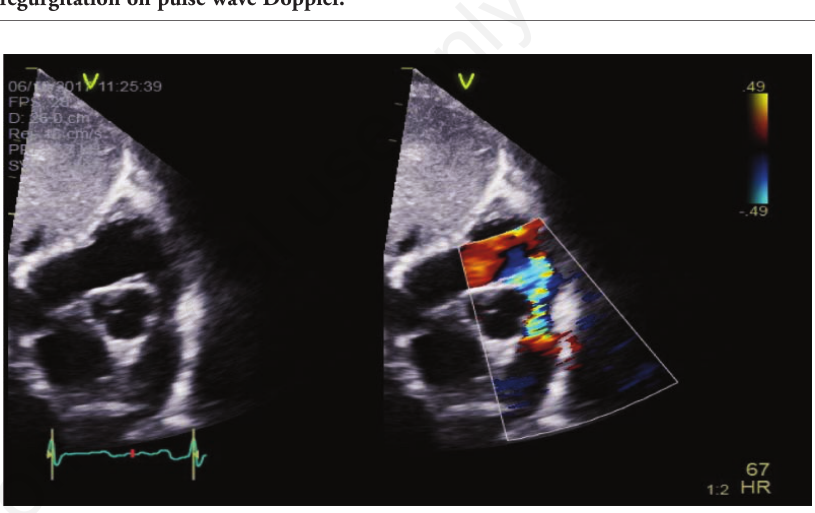
Figure 2. Echocardiography demonstrates thickened pulmonary valve leaflets and pul- monary stenosis (subcostal short axis view).